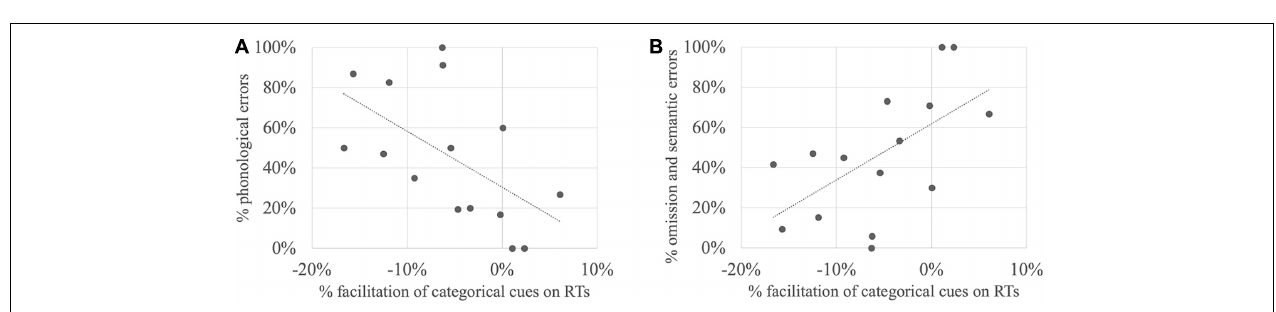
FIGURE 2 | Proportion of RT differences between related and unrelated conditions in individuals (dots) per subgroup and subgroup mean (“X”) (Mixed = mixed anomic profile, L-phon = lexical-phonological anomic profile, L-sem = lexical-semantic anomic profile) (A) for phonological auditory and auditory-visual cueing, (B) categorical semantic cueing, and (C) associative semantic cueing; negative values indicate facilitation after related cues and positive values interference.